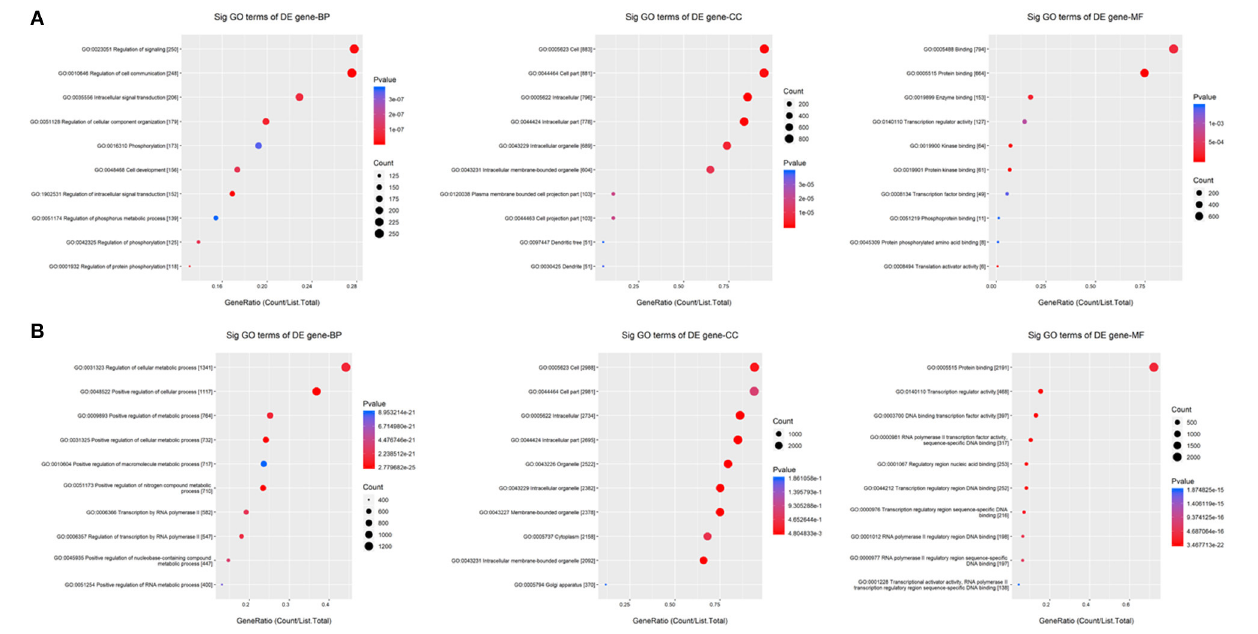
FIGURE 6 | GO enrichment for the targets of common differentially expressed miRNAs. (A,B) GO enrichment for the targets of up- and down-regulated common differentially expressed miRNAs, respectively. The ontology covers three domains: biological process, cellular component, and molecular function. Fisher’s exact test in Bioconductor’s top GO is used to determine whether there is more overlap between the miRNA targets list and the GO annotation list than would be expected by chance. The p -value of top GO denotes the significance of GO terms enrichment in the miRNA targets. The lower the p -value, the greater the significance of the GO Term.